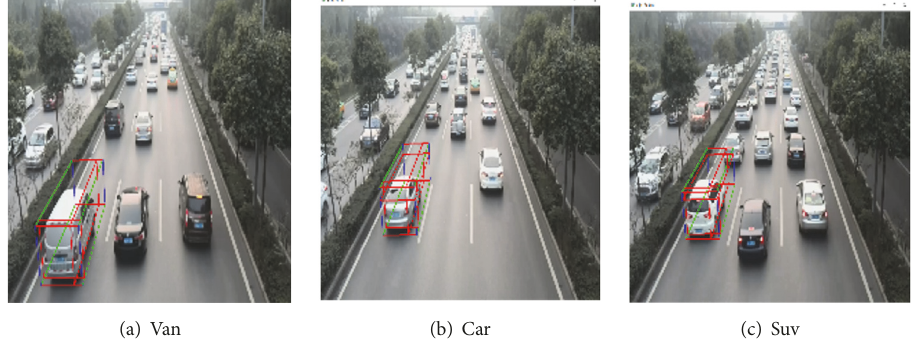
Figure 31: Location of the back-projection plane of the front and left views.